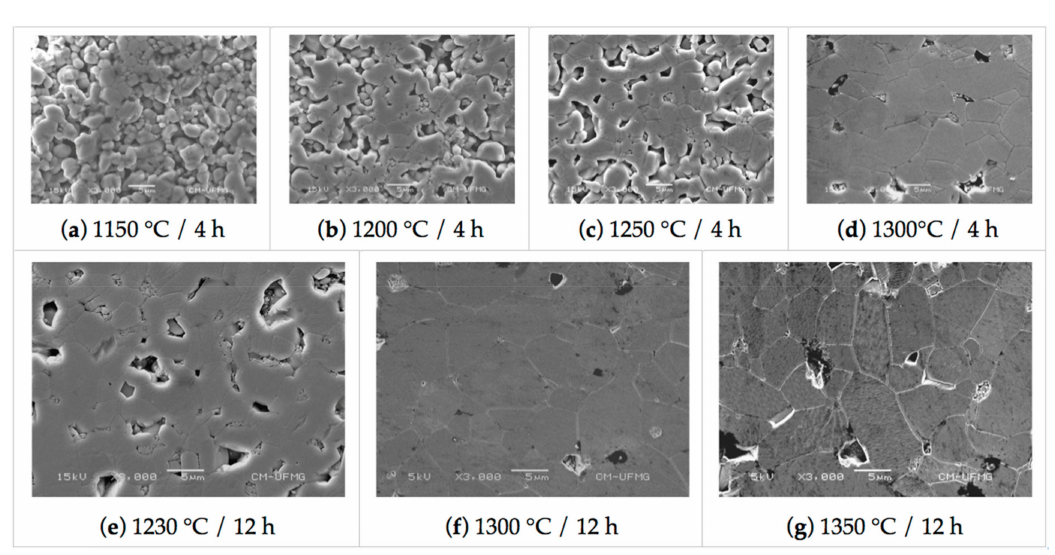
Figure 2. Images of TiO 2 polished samples at di ff erent sintering temperatures and times. SEM images were computionally treated by means of the ImageJ and Octave softwares.